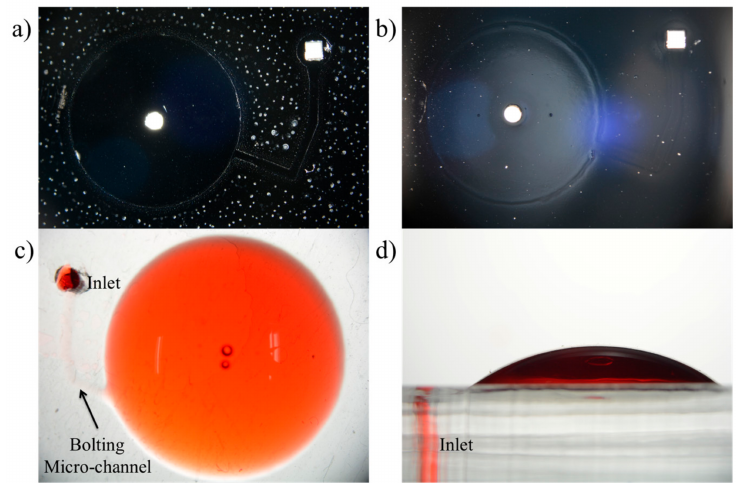
Figure 6. Surface treatment of PDMS by oxygen plasma and silanization. ( a ) Silanized PDMS surface was covered with the primary reservoir stencil (Figure 1b) and treated with oxygen plasma. ( b ) PDMS is dispensed over the treated surface and cured. Patterned surface can clearly be visualized. ( c ) Inflated primary chamber with inlet and bolting microchannel indicated with an arrow. ( d ) Side view of the inflated primary